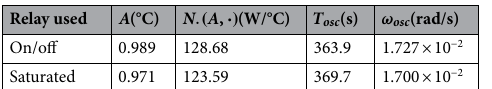
Table 1. Relay experiment data (without an artificial